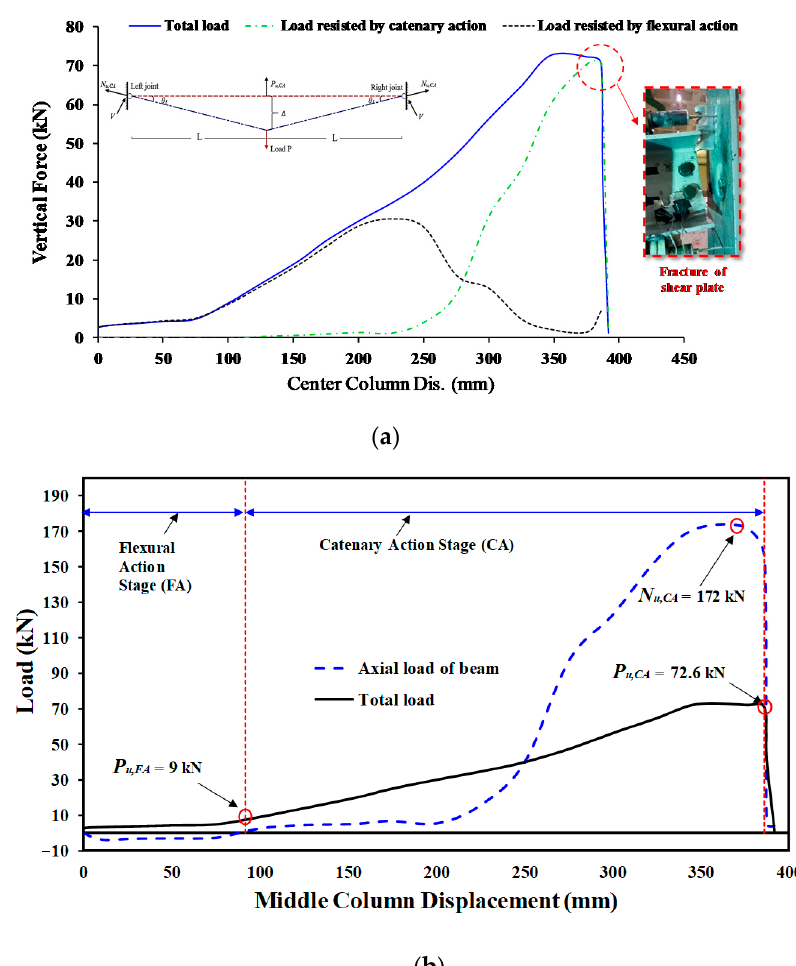
Figure 5. Characteristics of force and center steel-column displacement for J-S-C: ( a ) Curves of force and center column displacement, and ( b ) Curves of CA & flexural phases [6].